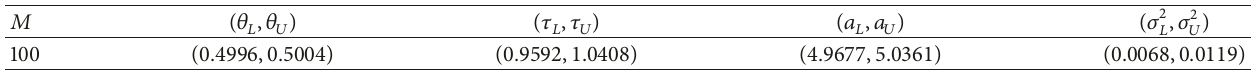
Table 3: Table showing the 95% confidence intervals for parameters 𝜃,𝜏, 𝑎 , and 𝜎 2 in